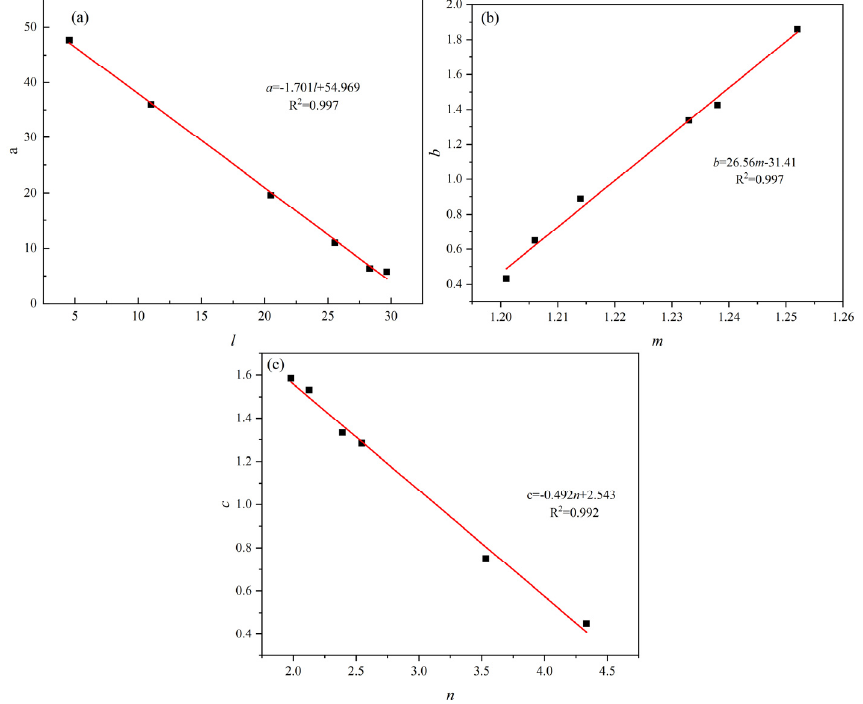
Figure 8. The relationship between fitted parameters (a) a~l, (b) b~m, and (c) c~n. Therefore, the PSD parameters b and c can be used to express the SWCC parameters a and n by means of Equations (8)–(10).